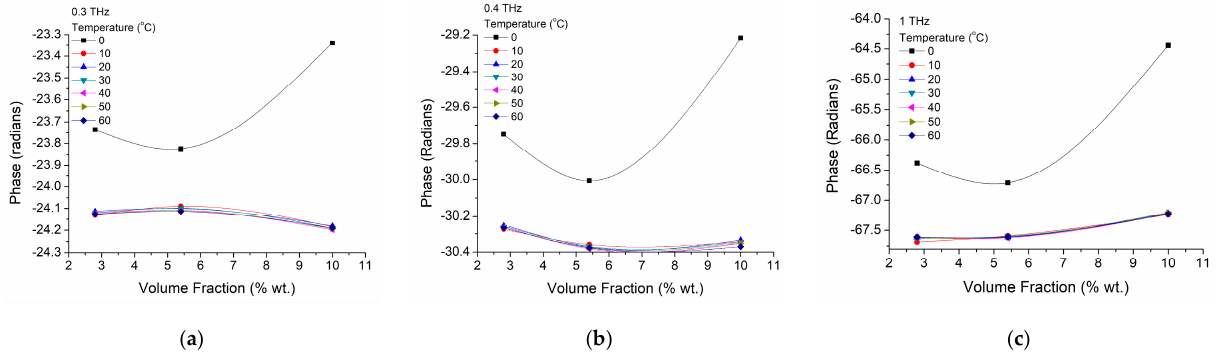
Figure 14. BTO-epoxy phase on nanoparticle volume fraction variation at different working frequencies of ( a ) 300 GHz, ( b ) 400 GHz, and ( c ) 1 THz and different temperatures.